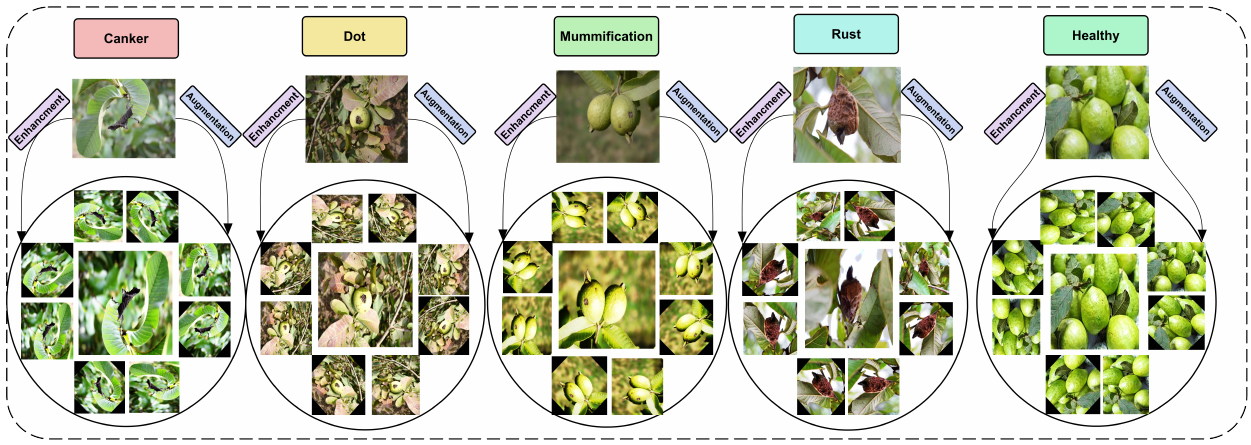
Figure 3. Five types of guava species image samples with their enhanced and rotated 9 angle images in circular view in 4